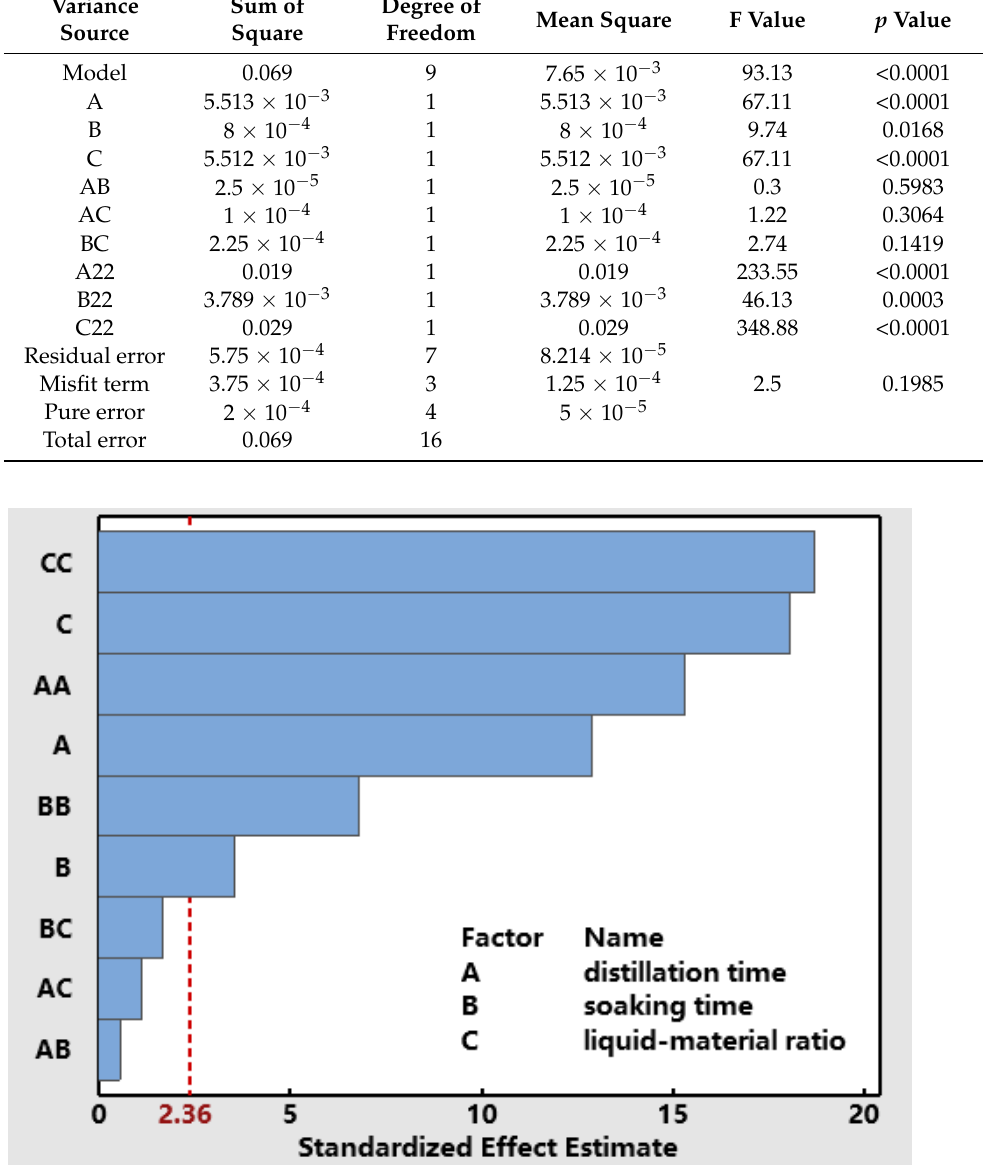
The response surface diagram and contour diagram of the distillation process of the volatile oil from Angelicae sinensis Radix are shown in Figure 7. The figure reflects the ef- fects of the distillation time, soaking time, and liquid – material ratio on the oil yield. When the liquid – material ratio is fixed, the oil yield increases first and then decreases gradually with the increase in distillation time. When the distillation time is too long, some volatile components in the volatile oil may volatilize and be lost. When the soaking time is fixed, the volatile oil yield increases first and then decreases gently with the increase in the dis- tillation time, and increases first and then decreases with the increase in the liquid – mate- rial ratio. When the distillation time is fixed, the oil yield increases first and then stabilizes with the increase in soaking time, and increases first and then decreases with the increase in the liquid – material ratio.